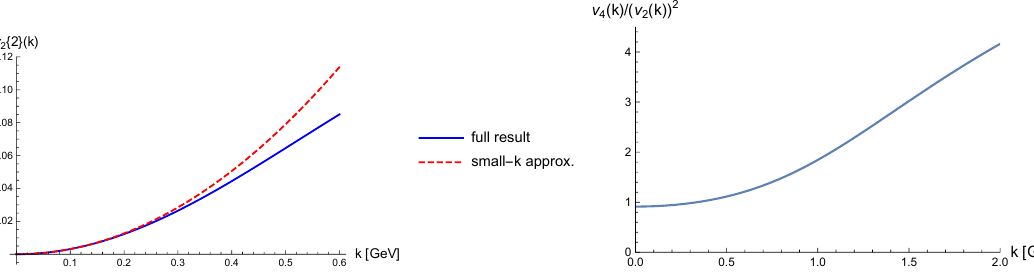
Figure 8 . L.h.s.: comparison of the second cumulant v 2 f 2 g ( k ) calculated from (3.14), and the approximation (4.13) for small transverse momentum. R.h.s.: the ratio of v 4 f 2 g ( k ) and ( v 2 f 2 g ( k )) 2 that is known to be constant in the limit of small transverse momentum. Both calculations are for B = 2 =GeV 2 and F (2) corr =